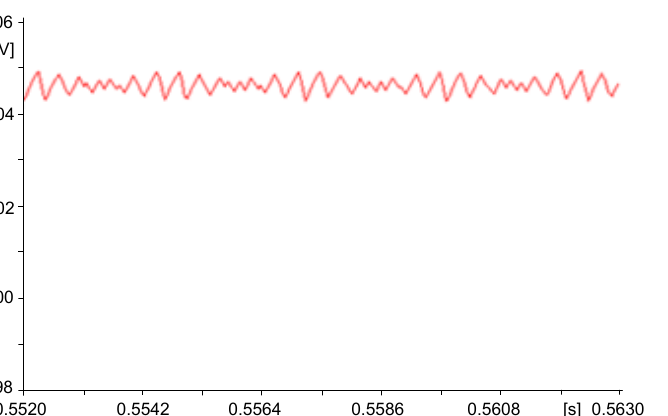
Figure 11. DC line voltage (two parallel DC/DC boost converters).